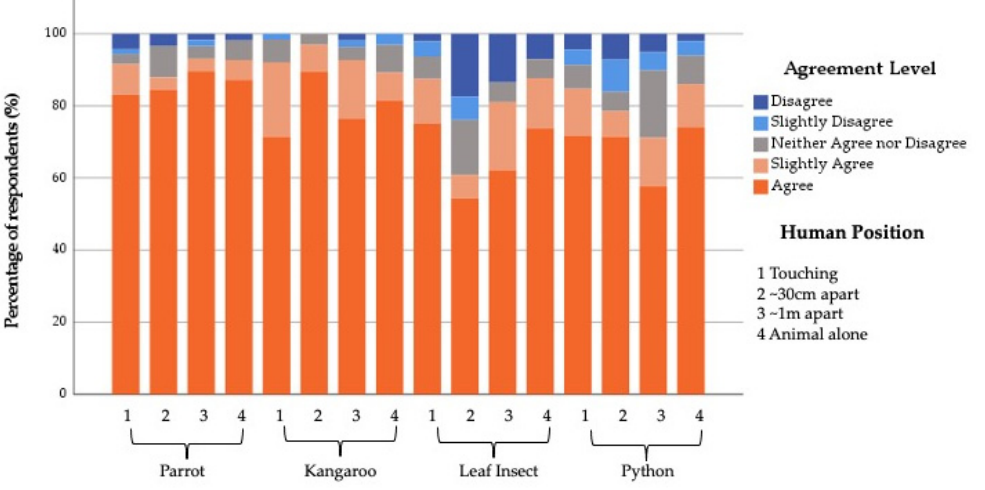
Figure 2. Percentage of Zoo Community respondents’ agreement with the statement “the featured animal is cared for by the zoo” in relation to the allocated images (Featured Animal by Human Position).